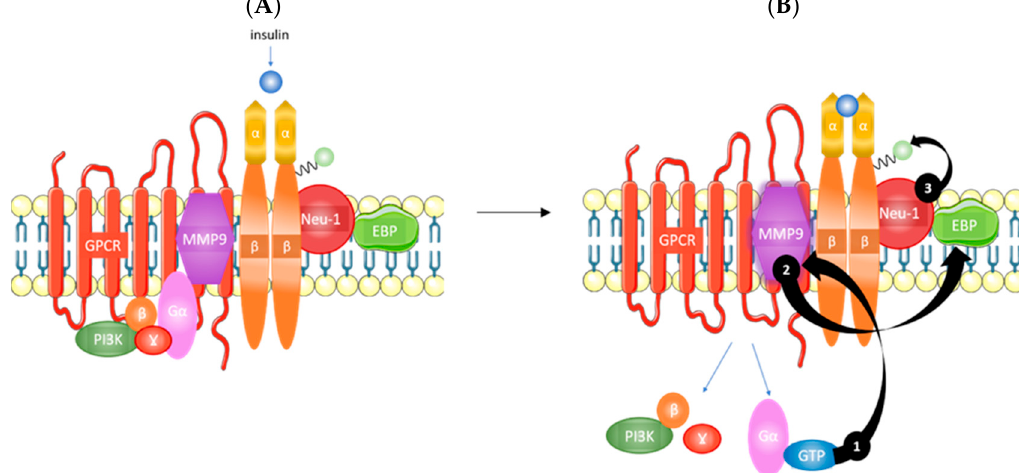
Figure 1. Overview of insulin signaling. ( A ) Insulin binding to the IR α and ( B ) potentiates GPCR signaling that activates MMP9 (1). Active MMP9 relieves restrictive EBP that activates Neu-1 (2). Activated Neu-1 cleaves α -2,3 sialic acid residues on IR β to remove steric hindrance and allow for receptor dimerization (3). IR α , α subunit of the insulin receptor; GPCR, G-protein coupled receptor; MMP9, matrix metalloproteinase 9; EBP, elastin binding protein; Neu-1, neuraminidase-1; IR β , β subunit of the insulin receptor; PI3K, phosphoinositide 3-kinase. Taken in part from